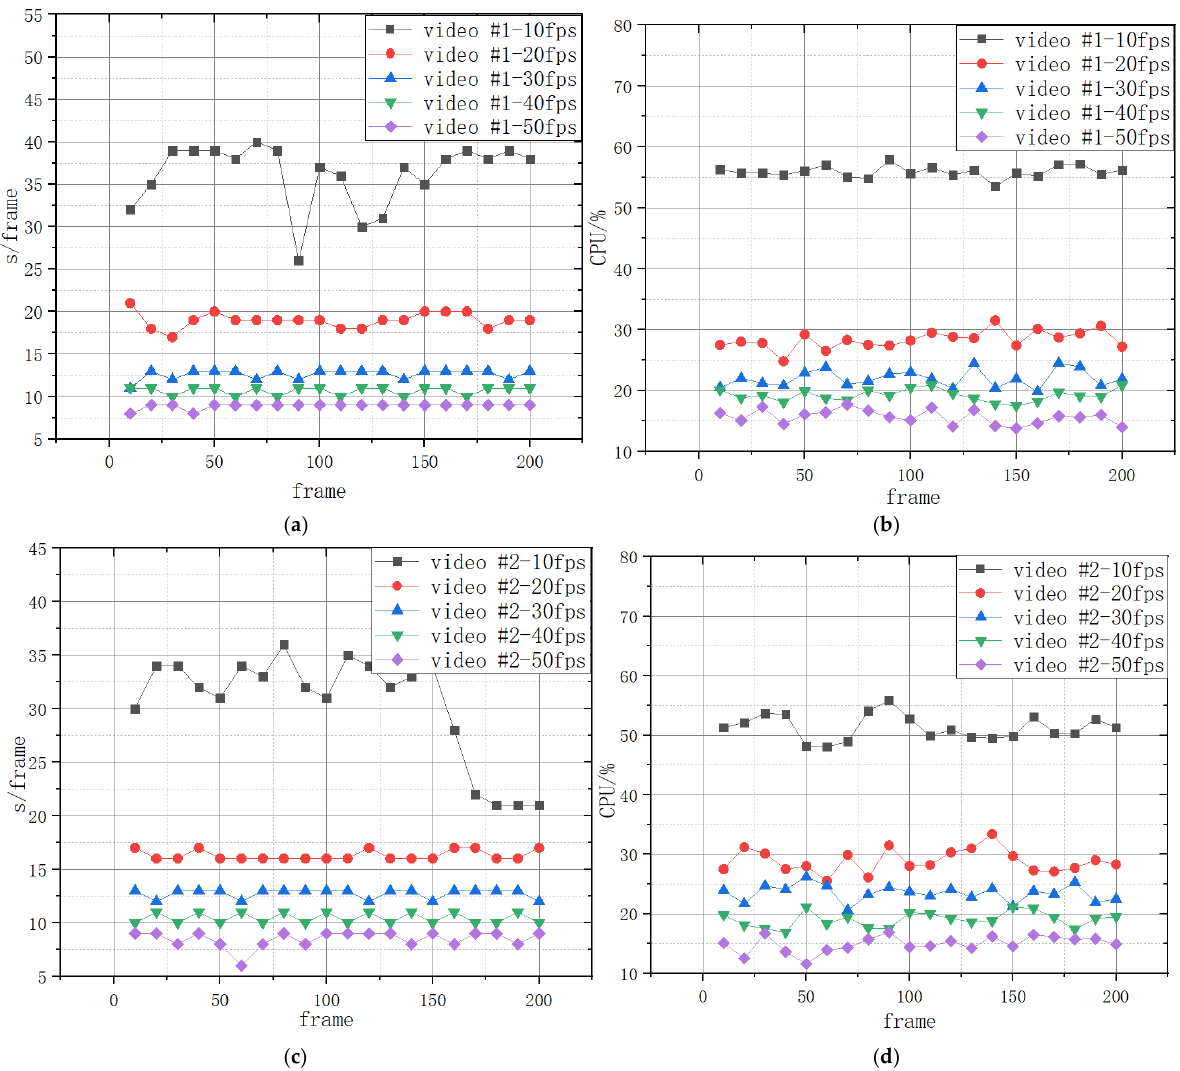
Figure 12. Algorithm performance of videos #1 and #2 at different frame rates: ( a ) the time efficiency of video #1; ( b ) the CPU occupancy percentage of video #1; ( c ) the time efficiency of video #2; ( d ) the CPU occupancy percentage of video #2;.